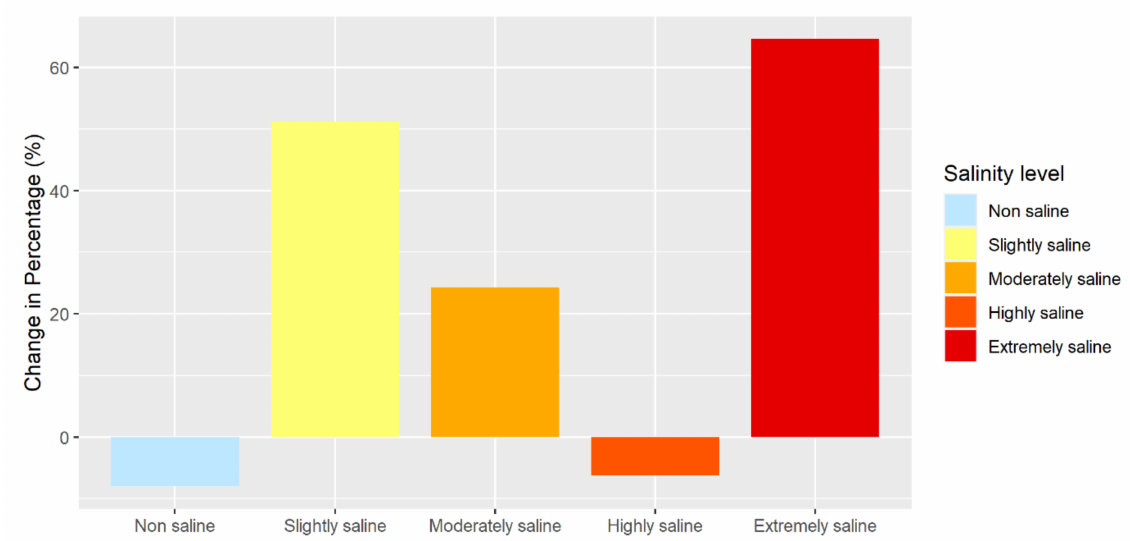
Figure 4. Changes in salt-affected areas per salinity class from 1988 to